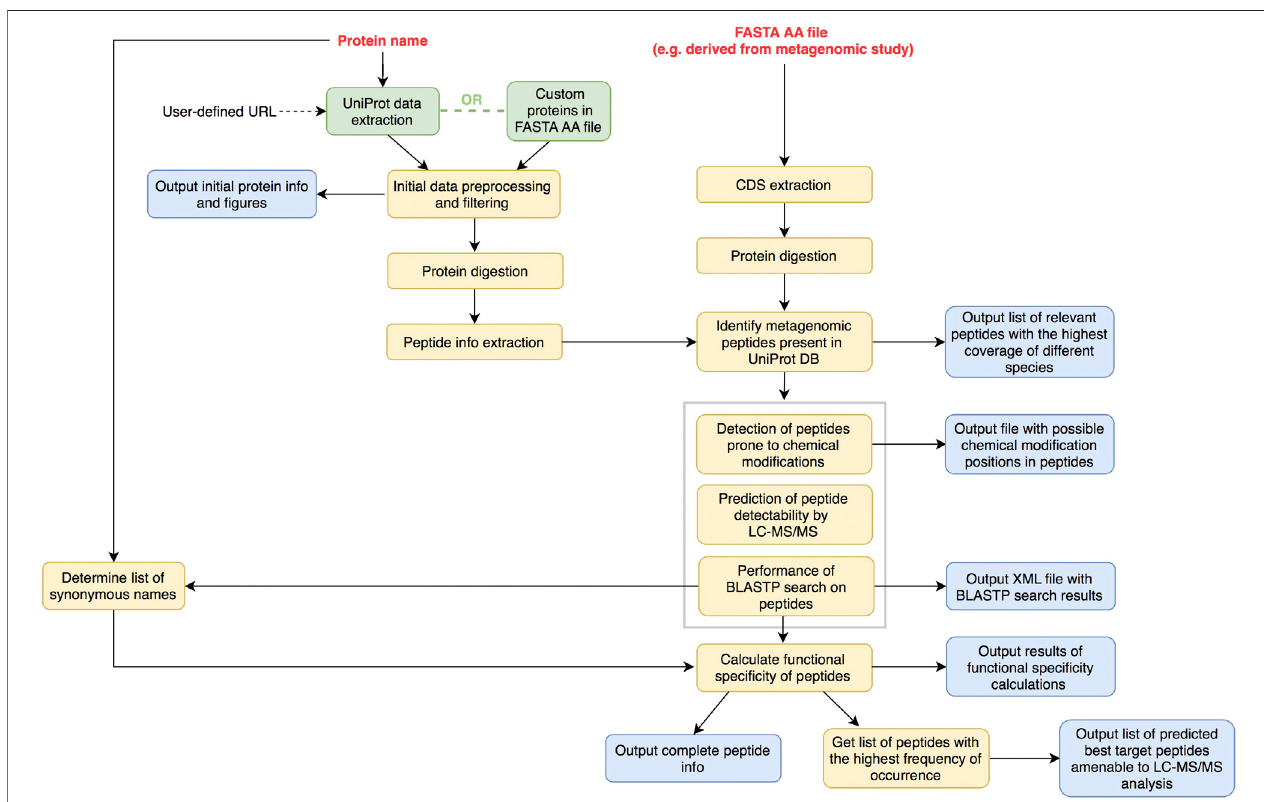
FIGURE 2 | Overview of optional peptide prediction mode work fl ow. User provides extra input fi le with protein sequences in FASTA AA format (e.g. derived from metagenomicsequencing).Theseproteinsaredigested insilico andresultingpeptidesarecomparedtothosederivedfromeitherUniProtDBorothertrustedsourcesof functionally annotated proteins. Exact matches only are then subjected to downstream data